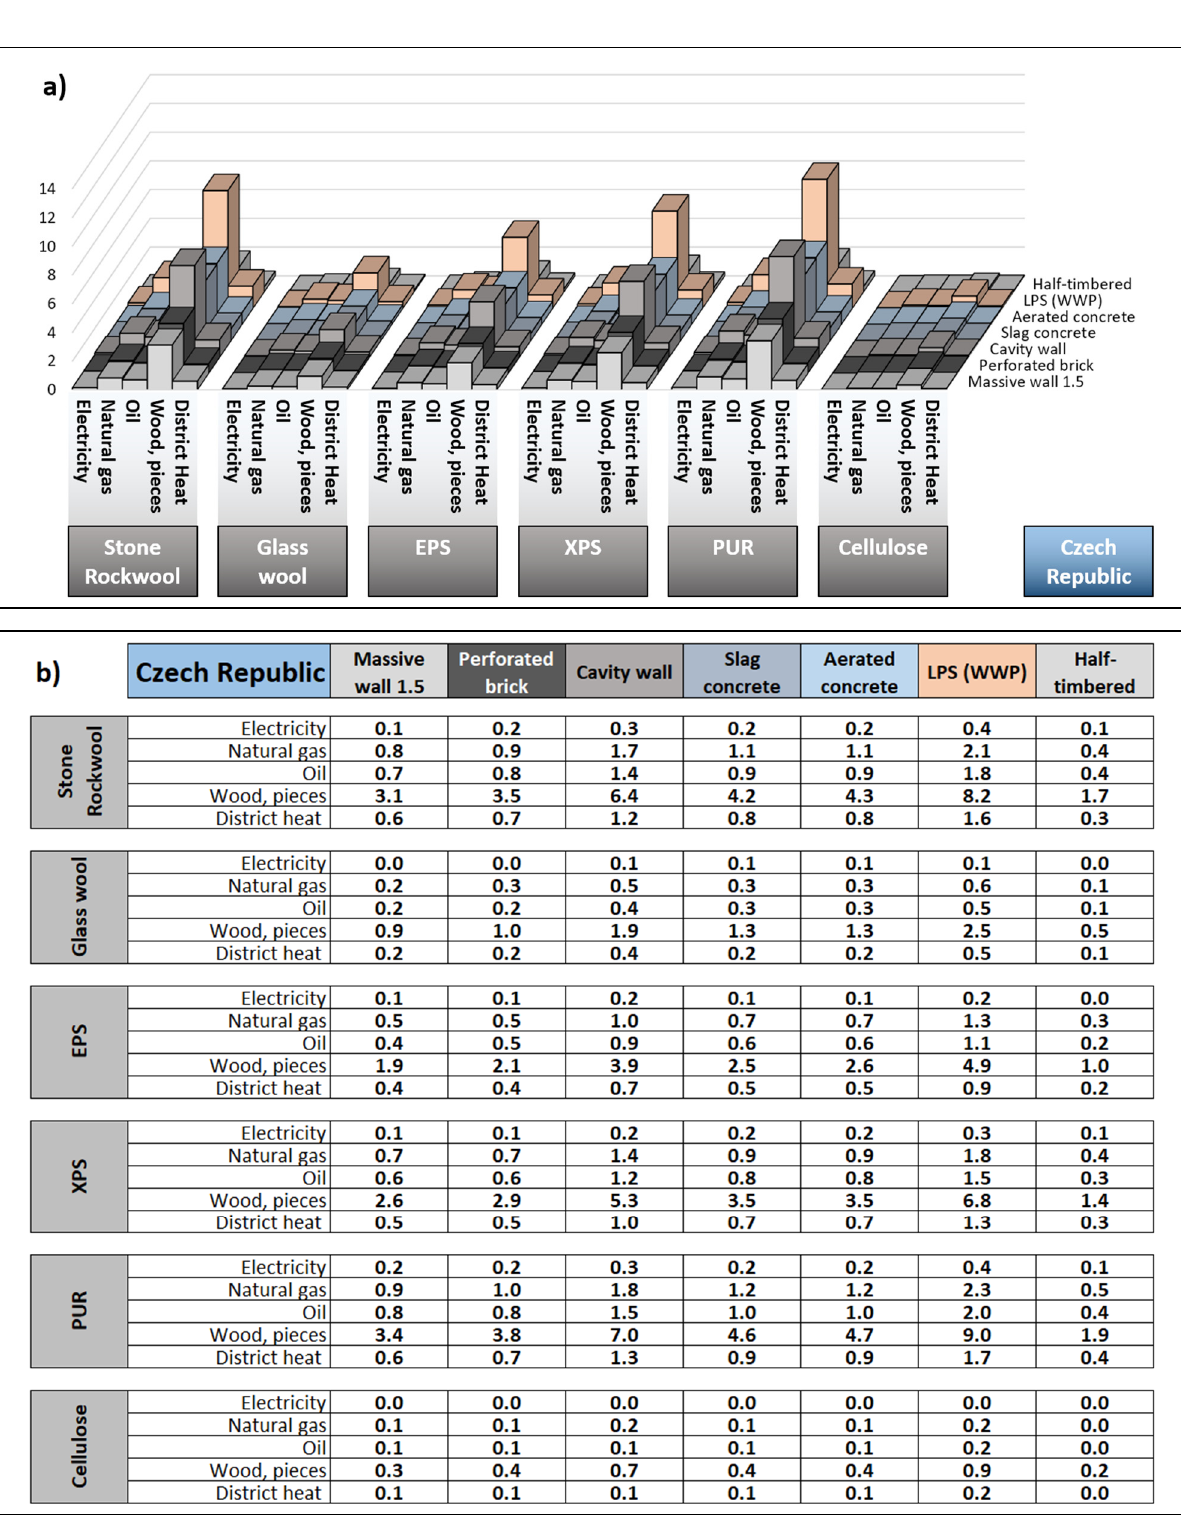
Figure 7. ( a ) CPP values chart for Czech Republic. ( b ) CPP values for Czech Republic. After averaging the data available from the EPDs available for the Czech Republic, PEFn values, emission factors and climatic conditions for Prague, the highest CPP values were found for the existing walls with the highest resistance, for spaces heated with biomass and for PUR insulation (up to 9.0 years), stone/rockwool (up to 8.2 years) and XPS (up to 6.8 years). The lowest CPP values are found for existing walls with the least resistance, for spaces heated with electricity and for cellulose, glass wool and EPS insulation (less than 0.1 year). Depending on the energy source, the average CPP ranges from 0.1 for electricity to 2.9 for biomass and, depending on the type of insulation, it ranges from 0.2 for cellulose to 1.7 for PUR, a phenomenon which is shown in Table 10a (CPP for various energy sources, regardless of the insulation method) and Table 10b (CPP for different in- sulation materials, regardless of the method of heating). Table 10. ( a ) Average CPP values for different energy sources. ( b ) Average CPP values for various insulation materials.